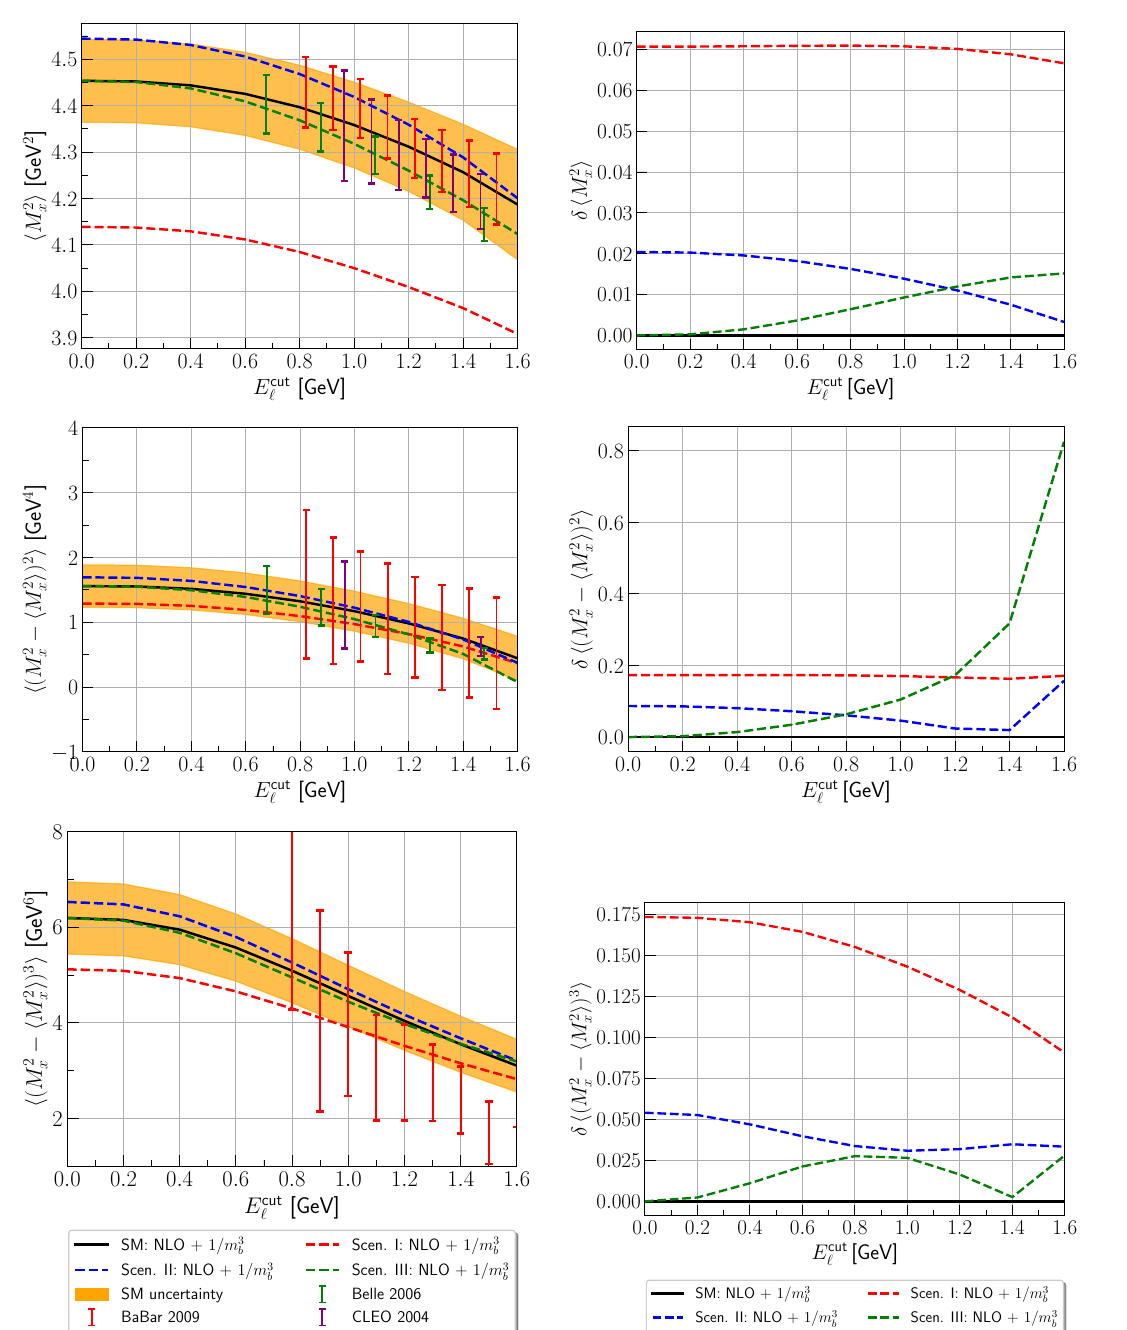
Figure 5. Hadronic invariant mass moments for the B → X c ‘ ¯ ν ‘ decay different NP scenarios